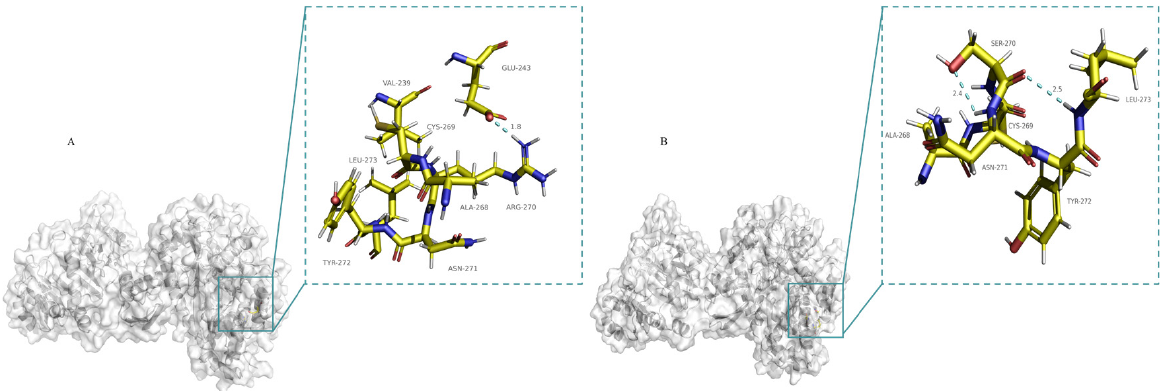
Figure 7. The hydrogen bond analysis. ( A ) The hydrogen bond analysis of WT; ( B ) The hydrogen bond analysis of R270S.